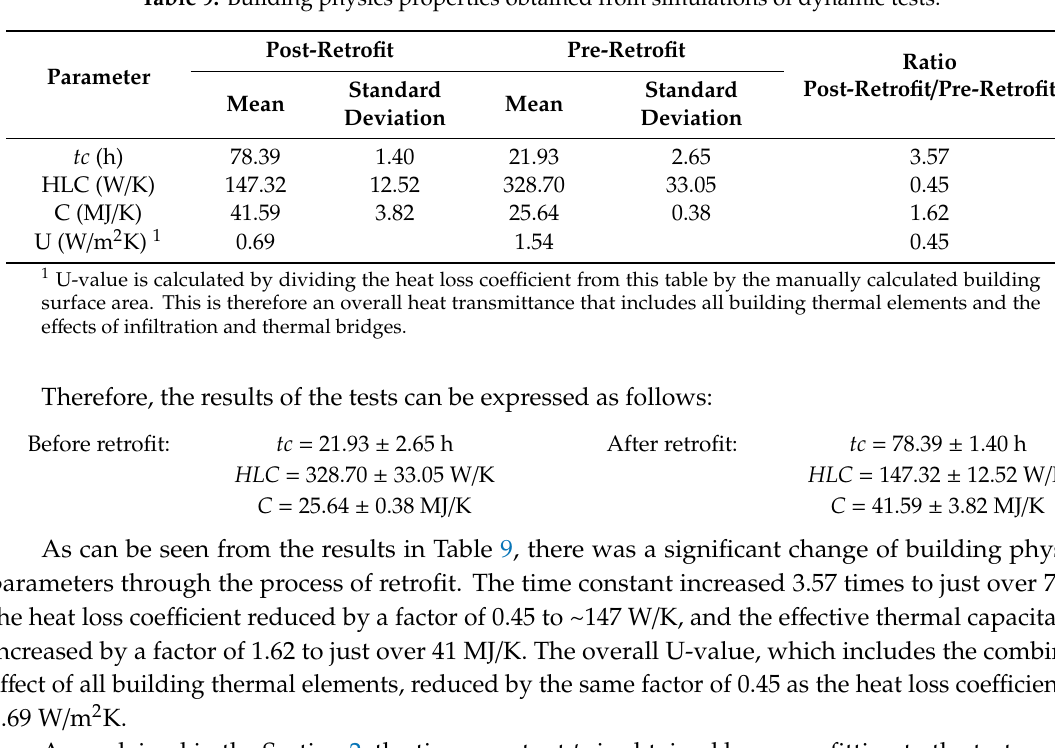
Table 9. Building physics properties obtained from simulations of dynamic tests.